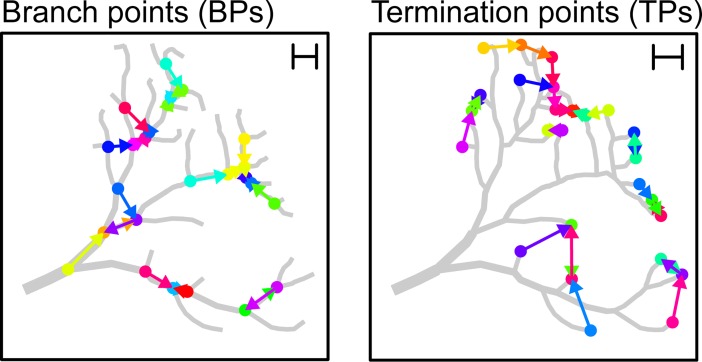
Sketch describing NN distances in BPs and TPs.Sample dendrite and NNs (colored arrows) between BPs (left) and TPs (right). The scale bar in the upper right corner shows the average NN distance, a measure that is crucial to determine the regularity index R.